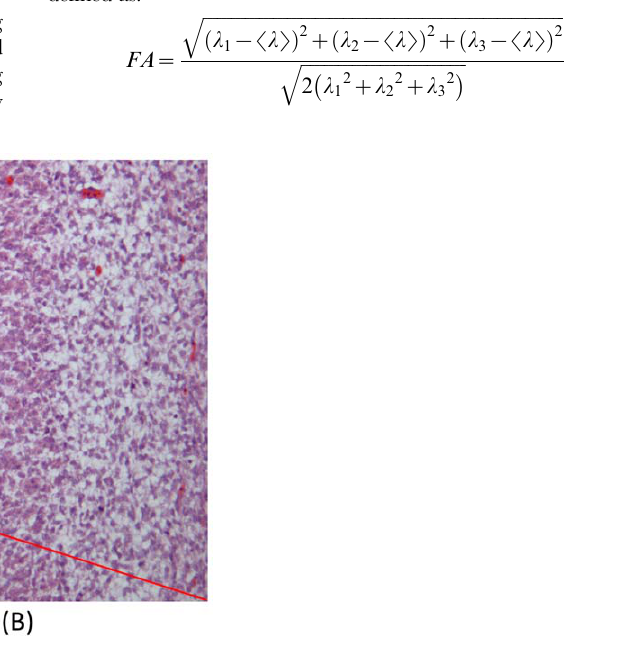
Figure 5. Example regions chosen for histologic sampling. ( A ) The chick embryonic gizzard at incubation day 9. ( B ) Micrograph (200 6 magnification, 1260 6 1400 resolution) of the red region of interest shown in (A).